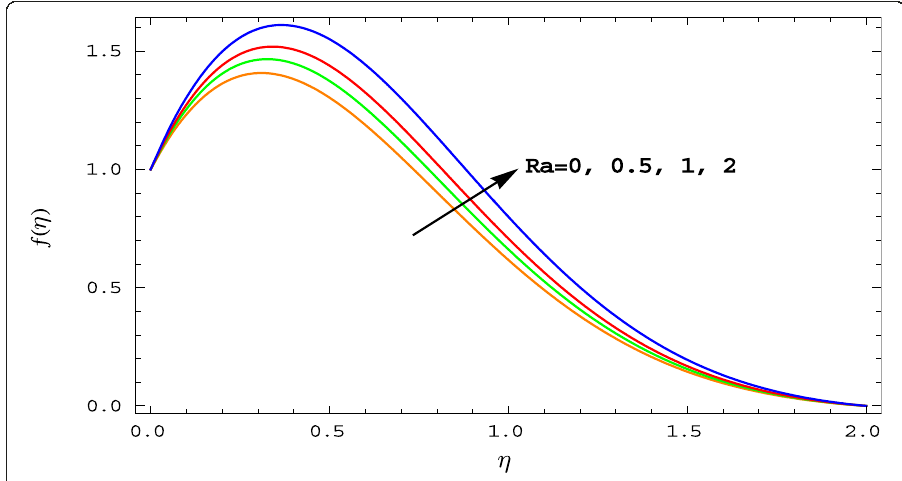
Fig. 14 Fluid velocity with increasing of the radiation parameter ( Ra )